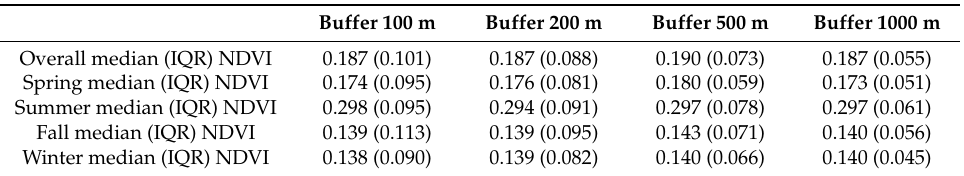
Table 2. Overall and season-specific normalized difference vegetation index (NDVI) values (median values and interquartile range